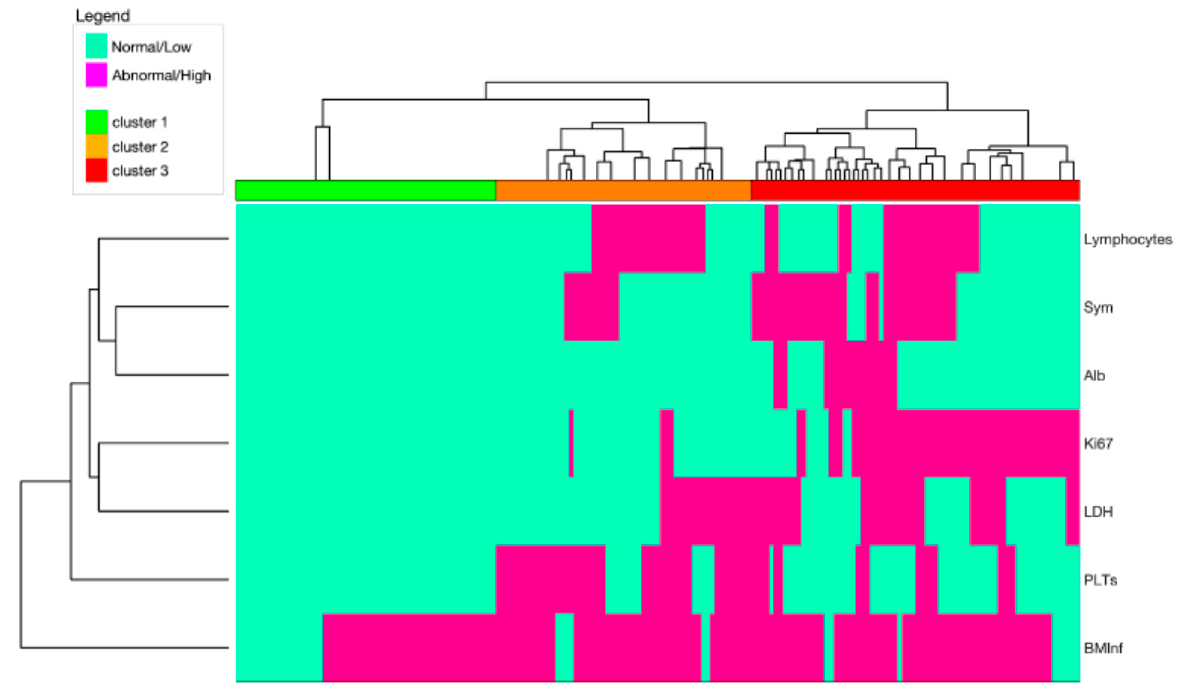
Figure 2. Heat-map of seven selected potential prognostic factors for MCL, based on a cluster analysis on training dataset. Light Green cells represent either normal or low values of the indicated variables; magenta cells represent either abnormal or high values of the indicated variables. Three large clusters emerged that were associated with Low (green), Intermediate (orange), and High (red) risk. Abbreviations. Sym: B symptoms; Alb: albumin; Ki67: cell proliferation marker; LDH: lactate dehydrogenase; PLTs: platelets; BMInf: tumor infiltration, assessed with immunohistochemistry on a bone marrow biopsy.